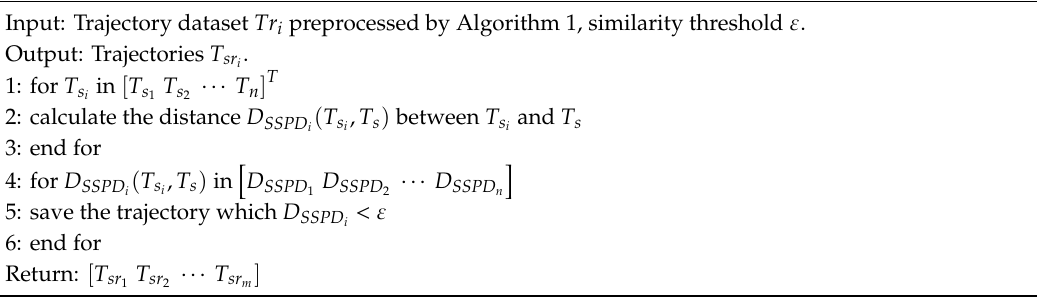
Algorithm 2: Trajectory Similarity Measurement